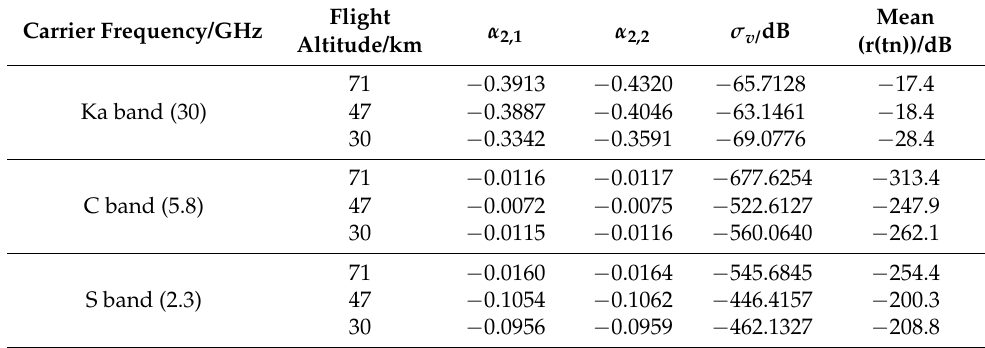
Table 1. Value of parameters in the autoregressive (AR) model.